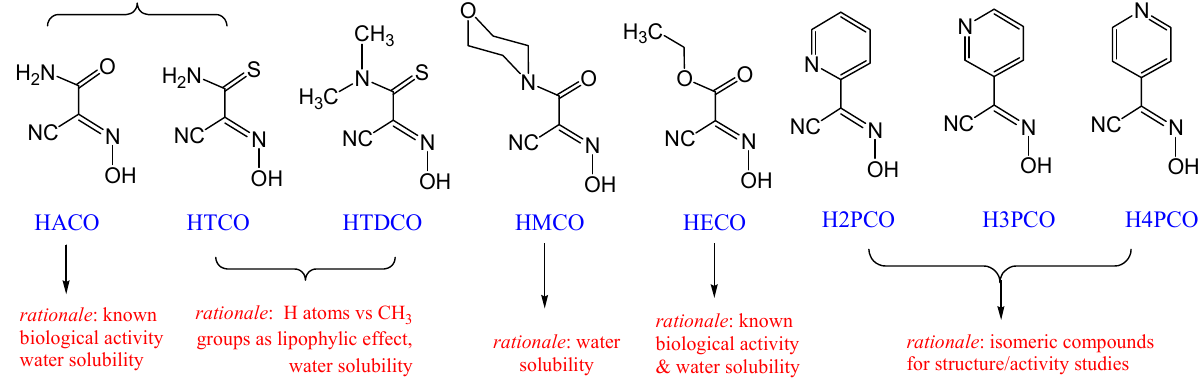
Figure 2. Chemical structures of cyanoximes used in this work, together with their commonly adopted abbreviations, and rationalized choice for these specific